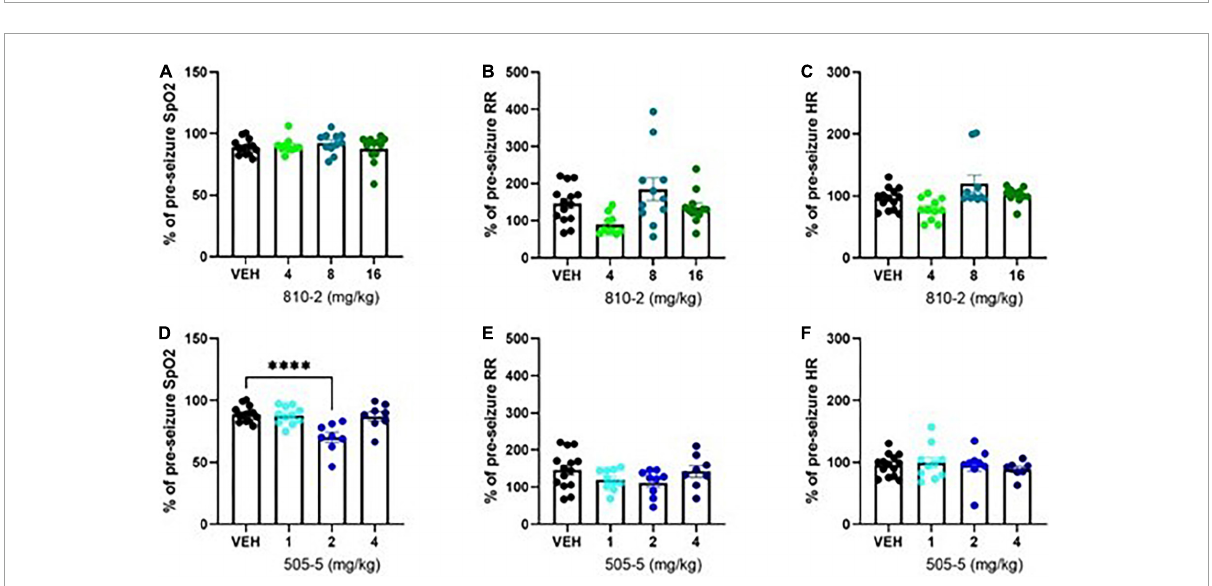
FIGURE2 Evaluation of cardiorespiratory parameters following tonic extension in CF-1 mice. Data are presented as a percentage of baseline (pre-seizure) values. VEH-treated values are the same as shown in Figure 1 , except expressed as a percent of baseline. A total of 810–2 (A–C) and 505–5 (D–F) were administered by IP injection 1 h prior to tonic extension and testing (MouseOx). Oxygenation [SpO 2 ; (A,D) ], respiratory rate [RR; (B,E) ], and heart rate [HR; (C,F) ] were assessed for all animals. N = 8–14. ∗∗∗∗ P < 0.0001 (One-way ANOVA, Sidak’s multiple comparison post-hoc